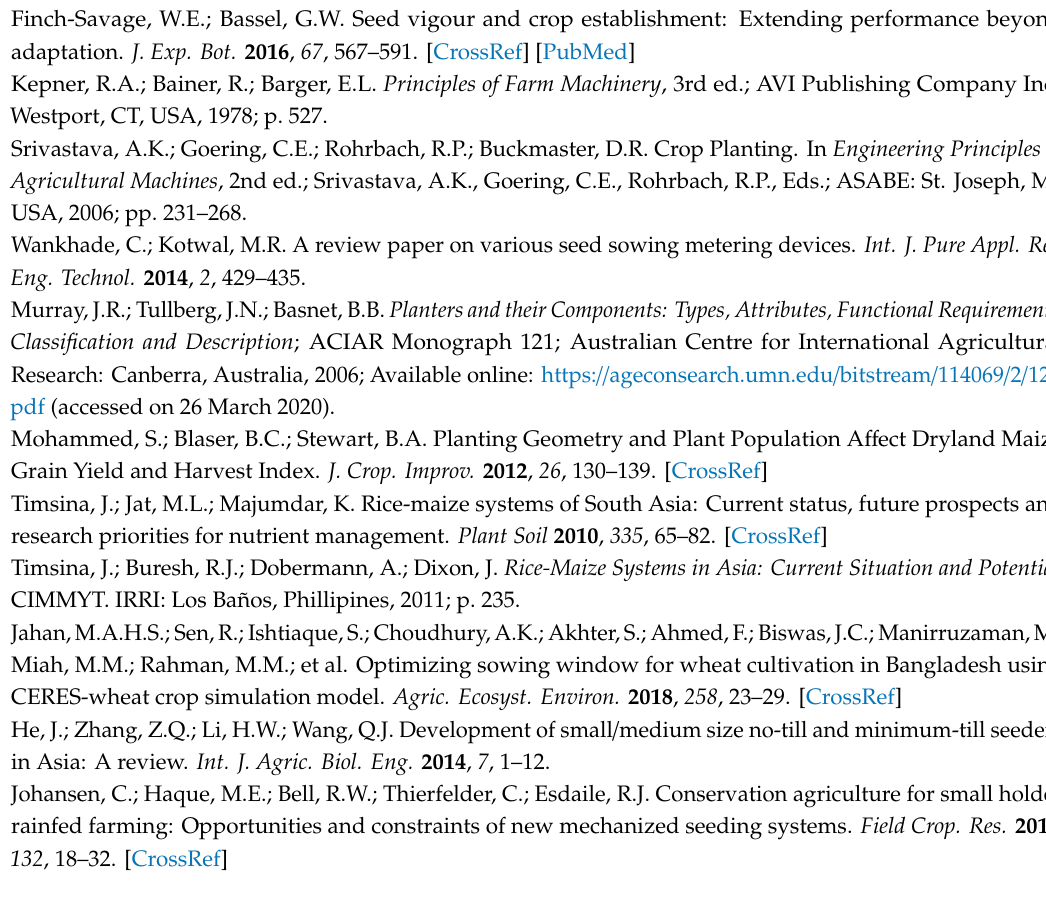
Figure S1: Schematic representation of the fixed-frame test-bench, Figure S2: Bridge set up at CENEMA with steps for adding an angle to the structure and a set of 3 seed meters mounted on a fixed frame during the trails, Figure S3: Schematic of the vibration generation mechanism of the test-bench, Figure S4: The National Agro Industries inclined plate seed meter, Figure S5: The BARI 24-cell inclined plate seed meter, Figure S6: Sembradoras TIMS inclined plate seed meter, Figure S7: The BARI -9-cell inclined plate seed meter, Figure S8: VMP-12 vertical plate seed meter, Figure S9: Finger vertical plate seed meter system, Figure S10: Close up of seed drop position adjustment mechanism of the finger vertical seed meter system, Figure S11: Sembradoras del Bajio horizontal Plate Seed meter system, Figure S12; Fitarelli horizontal plate seed meter system, Figure S13: 2BGF sliding fluted roller seed meter system, Figure S14: The Terradonis celled roller seed meter